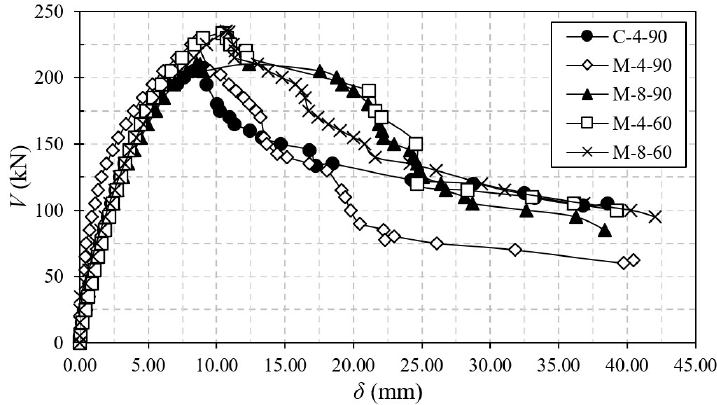
Figure 8 – Shear force versus Deflection of the